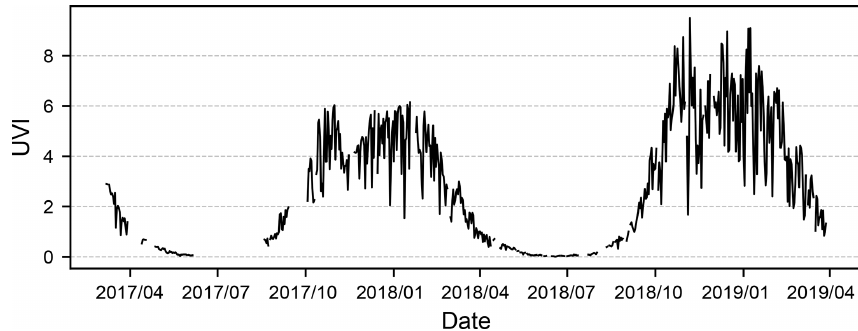
Figure 4. Daily maximum UV indices in Marambio from March 2017 to March